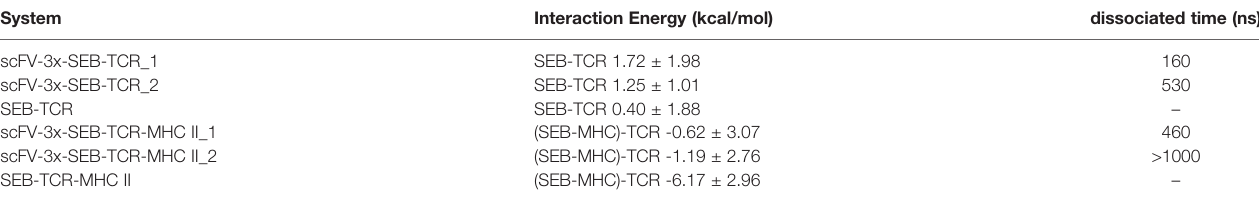
TABLE 2 | The interaction energy and dissociated time of SEB-TCR.